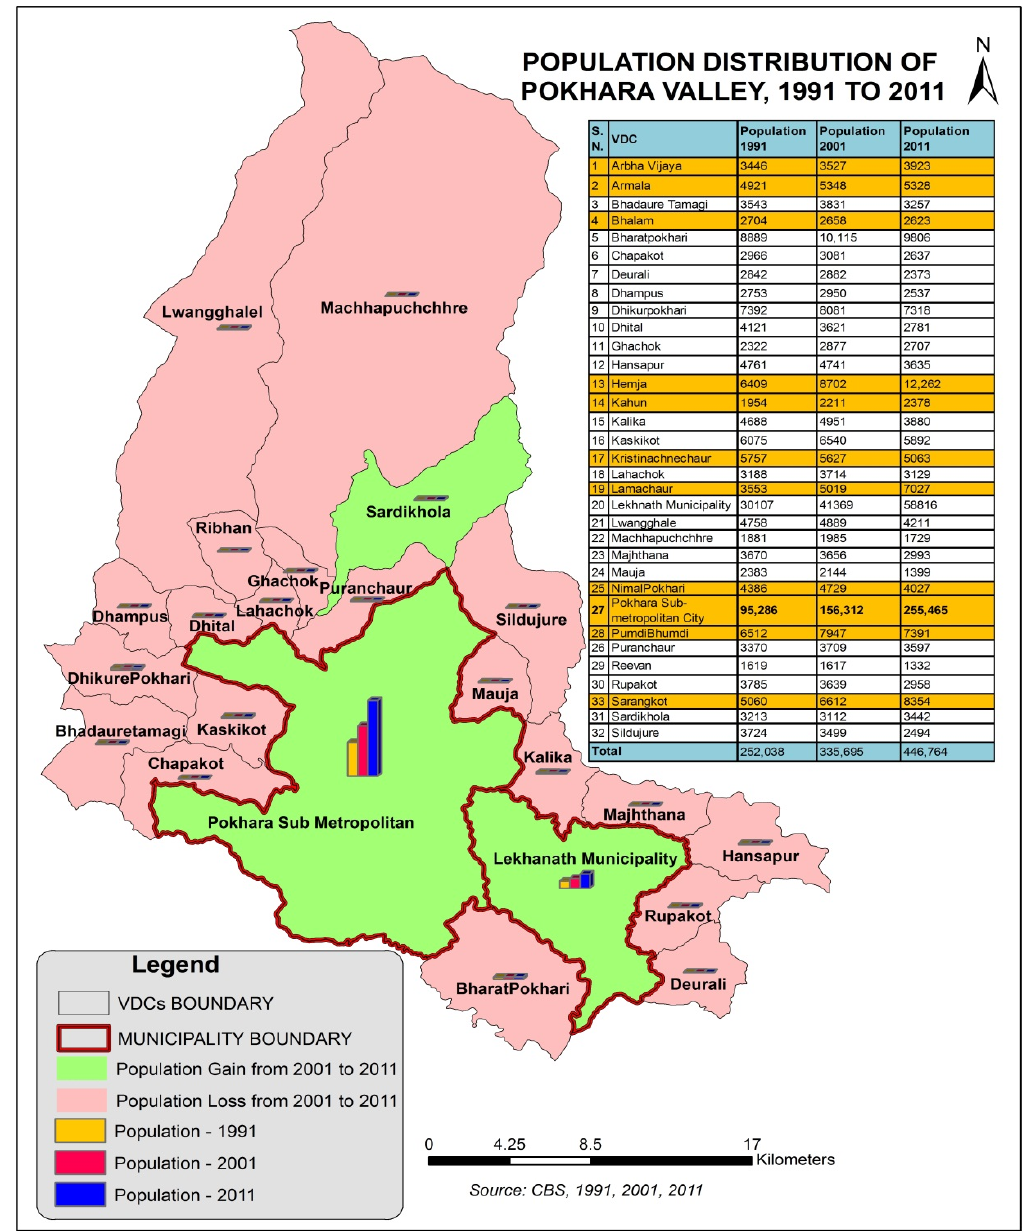
Figure 3. Population distribution map. Note: The total area of the sub-metropolitan city was 55.31 km 2 , which expanded to 226 km 2 by 2014 after the annexation of the other